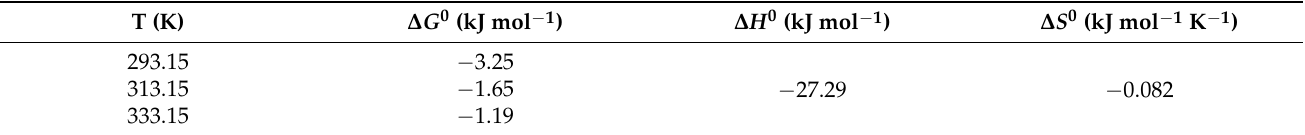
Table 3. Thermodynamic parameters for TC adsorption onto CS · Fe 3 O 4